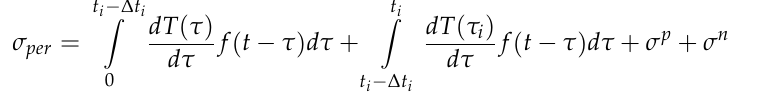
Figure 3. The course of stresses in rotor critical areas calculated using online stress monitoring algorithm (based on Green’s functions) and FEM .